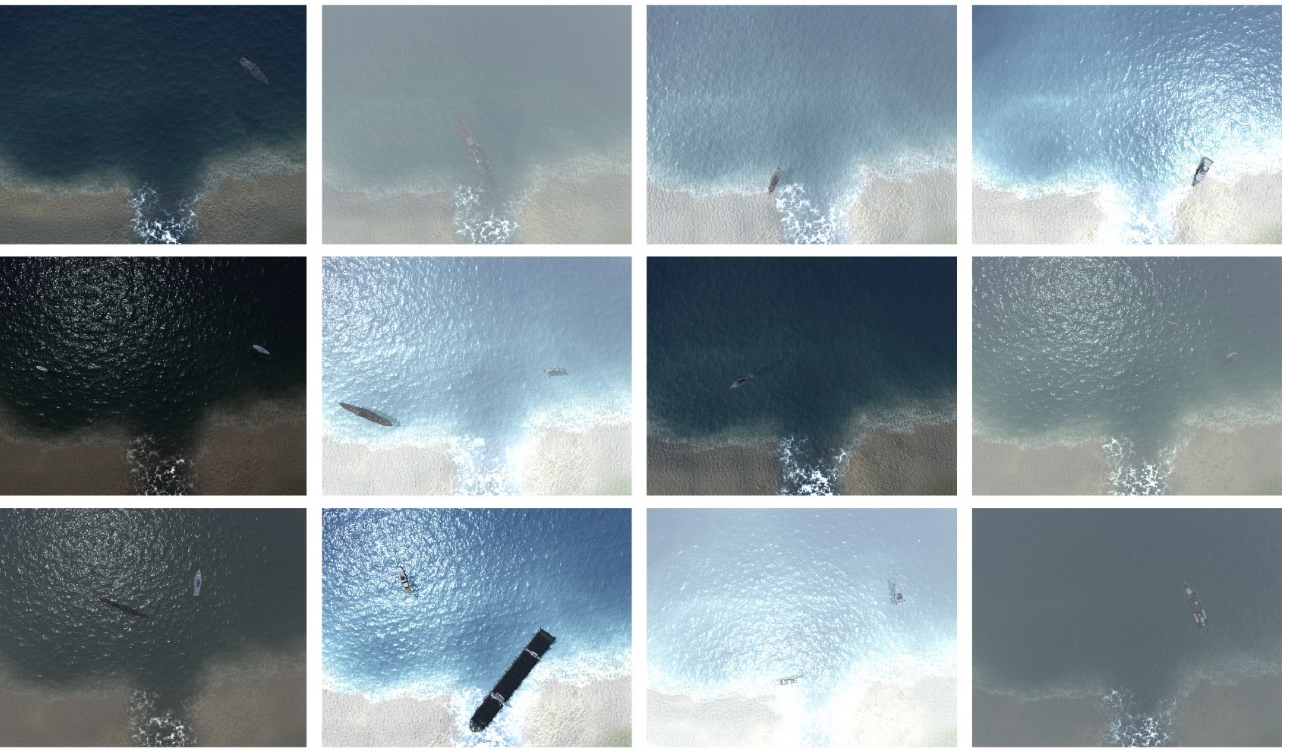
Figure 2. Examples of random environment property settings at the same location.